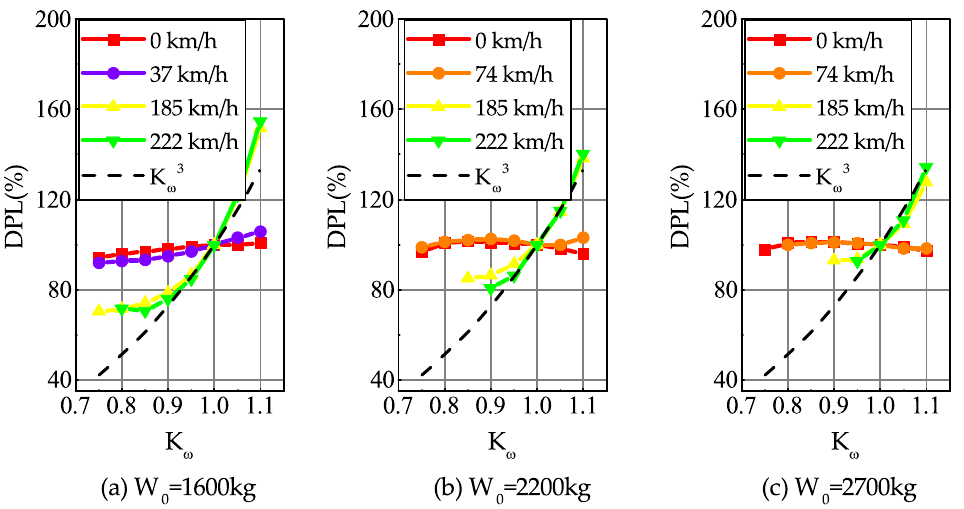
Figure 5. Variation in direct power loss (DPL) with rotor speed for different take-off weights. A dimensionless parameter analysis is applied to separate the variable-speed rotor performance from the dynamic pressure. The conditions of slow flight are listed in Table 2. It is noticed that the three cases have different true flight parameters, but the same advance ratio and blade loading